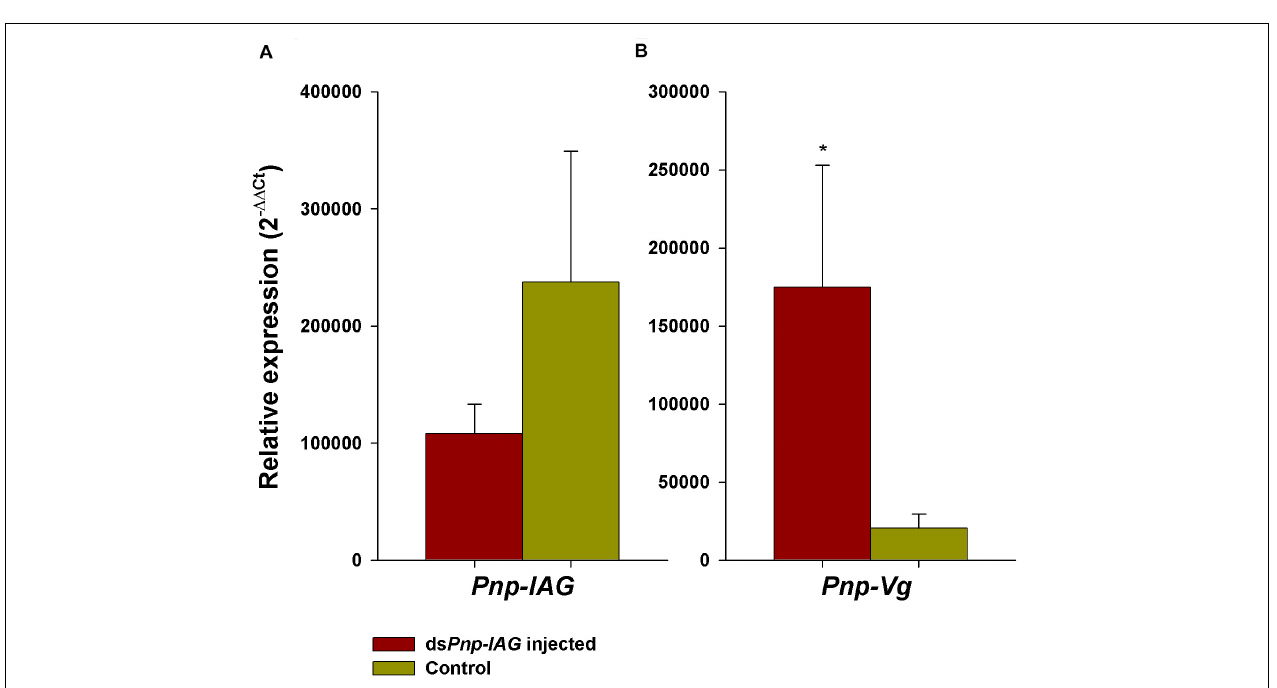
FIGURE 3 | Short term Pnp-IAG loss of function through RNAi. (A) Relative expression of Pnp-IAG and (B) Pnp-Vg in P. platyceros males injected with ds Pnp-IAG (red, n = 10) or with crustacean saline (control; green, n = 8). Error bars represent standard error of the means. * P <